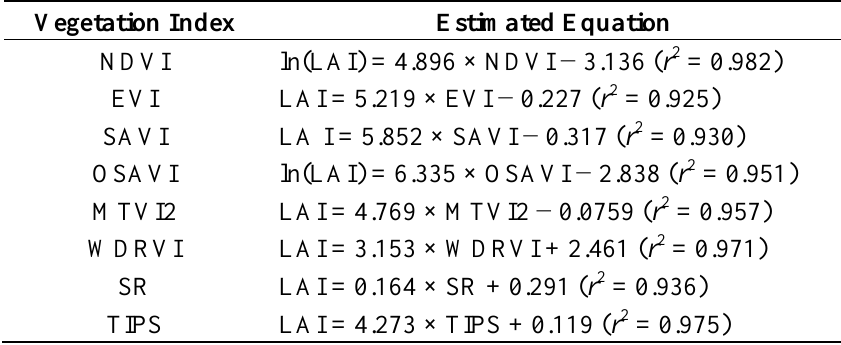
Table 3. Estimated regression equations for each vegetation index in 2008 and 2009. Values in parentheses ( r 2 ) are coefficients of determination.